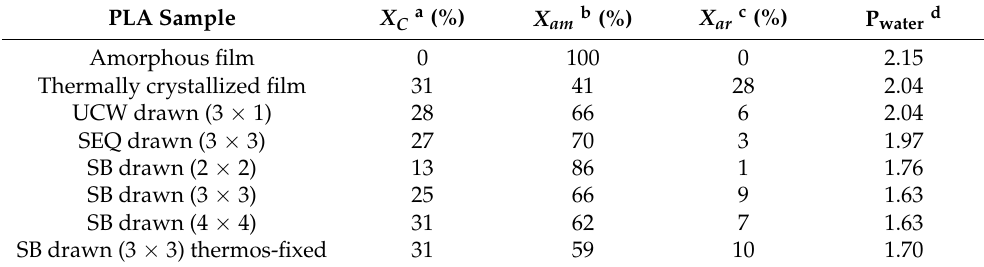
Table 3. Values related to samples’ crystallinity degree ( X c ), mobile amorphous phase degree ( X am ), rigid amorphous fraction degree ( X ar ) as well as permeability coefficient P. Data taken from [62]. PLA Sample X C a (%) X am b (%) X ar c (%) P water d Amorphous film 0 100 0 2.15 Thermally crystallized film 31 41 28 2.04 UCW drawn (3 × 1) 28 66 6 2.04 SEQ drawn (3 × 3) 27 70 3 1.97 SB drawn (2 × 2) 13 86 1 1.76 SB drawn (3 × 3) 25 66 9 1.63 SB drawn (4 × 4) 31 62 7 1.63 SB drawn (3 × 3) thermos-fixed 31 59 10 1.70 a Crystallinity degree. b Mobile amorphous phase degree. c Rigid amorphous fraction degree. d Water permeability coefficient (10 − 12 mol m − 1 s − 1 Pa − 1